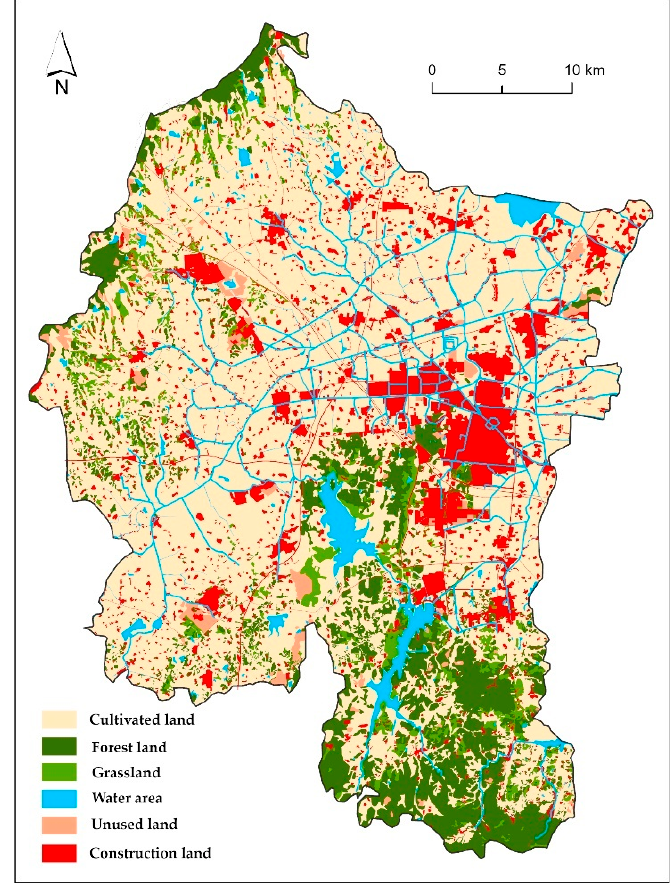
Figure 2. Land-use map of the study area.